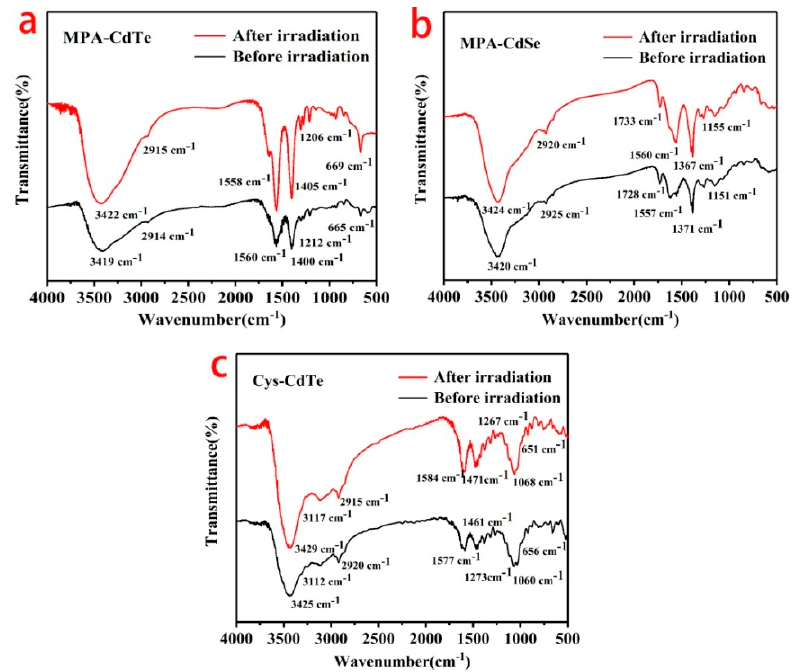
Figure 5. FTIR spectra of MPA-CdTe ( a ), MPA-CdSe ( b ) and Cys-CdTe ( c ) QDs before and after 10 kGy γ -irradiation.